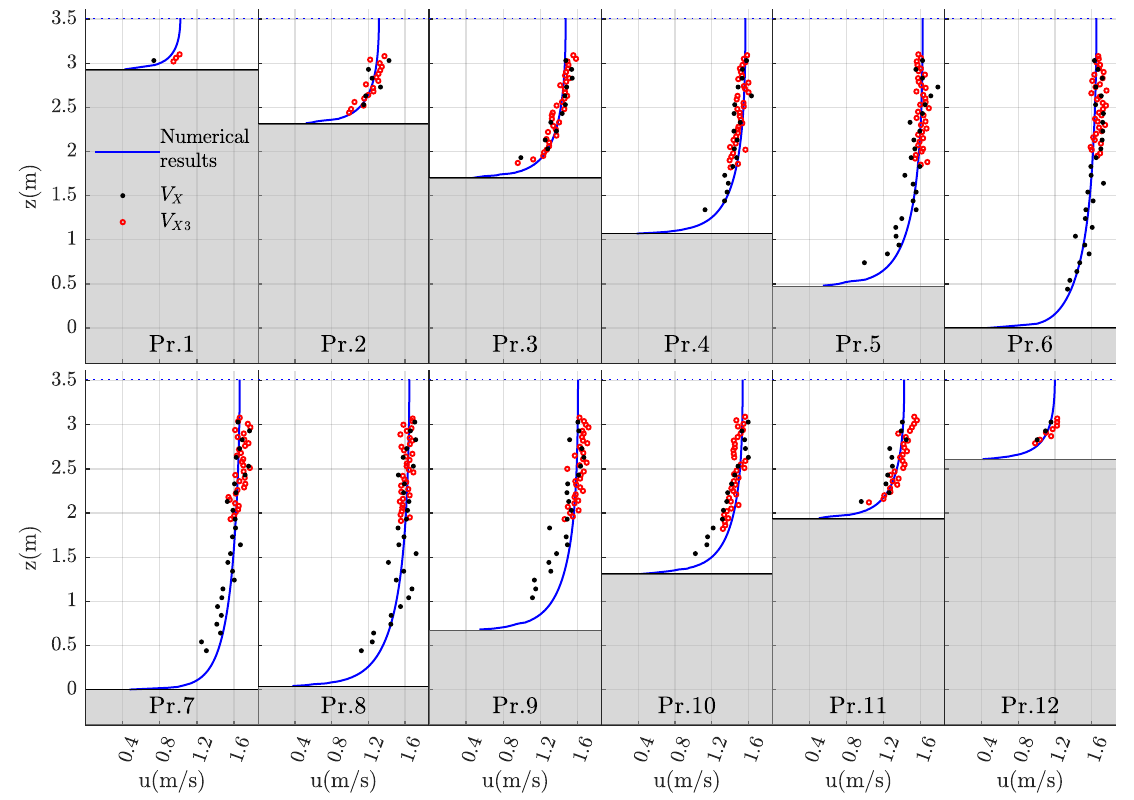
Figure 5. Measured velocities ( V X and V X 3 ) and hydraulic model results for measured verticals in measurement 3b in section GG11.